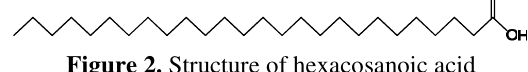
Figure 2. Structure of hexacosanoic acid